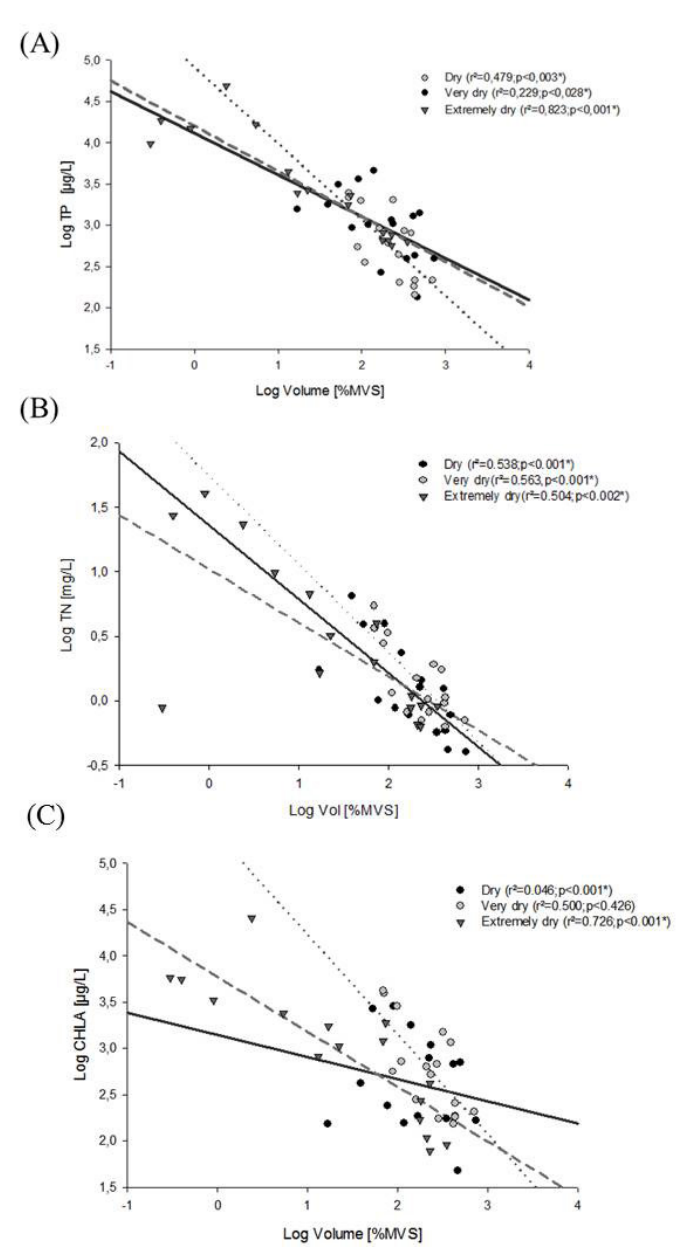
Figure 4. Simple linear regressions relating the percentage of maximum water volume storage (% MVS) and the total concentrations of total phosphorus (A), total nitrogen (B) and chlorophyll-a (C). The continuous, dashed and pointed lines represent the dry, very dry and extremely dry periods, respectively. The asterisk (*) denotes that the regression model was